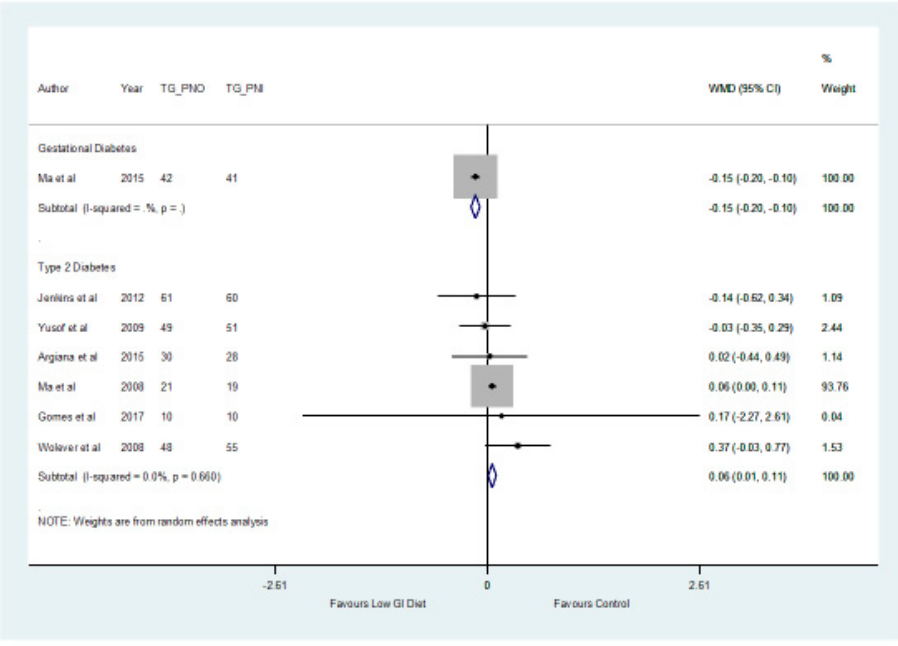
Figure 7. A forest plot depicting the effect of a low GI diet on Triglyceride (mmol/L).